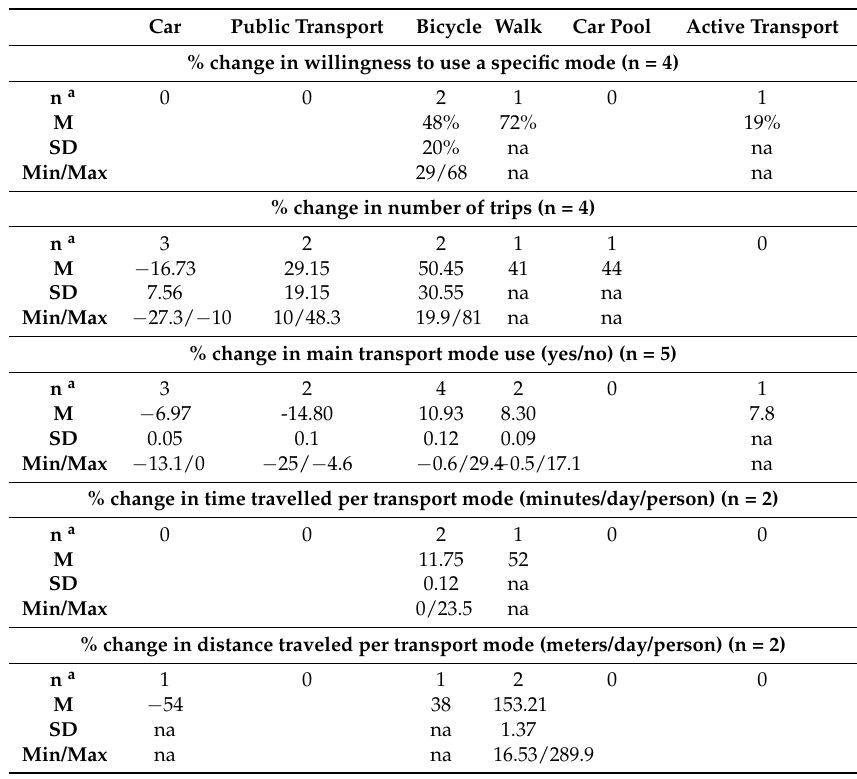
a Number of studies reporting the outcome